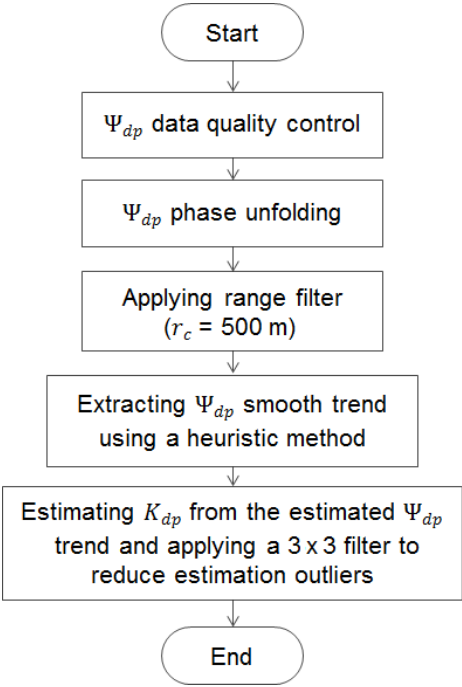
Figure 3. The NRC K dp estimation algorithm for X-band radar flow